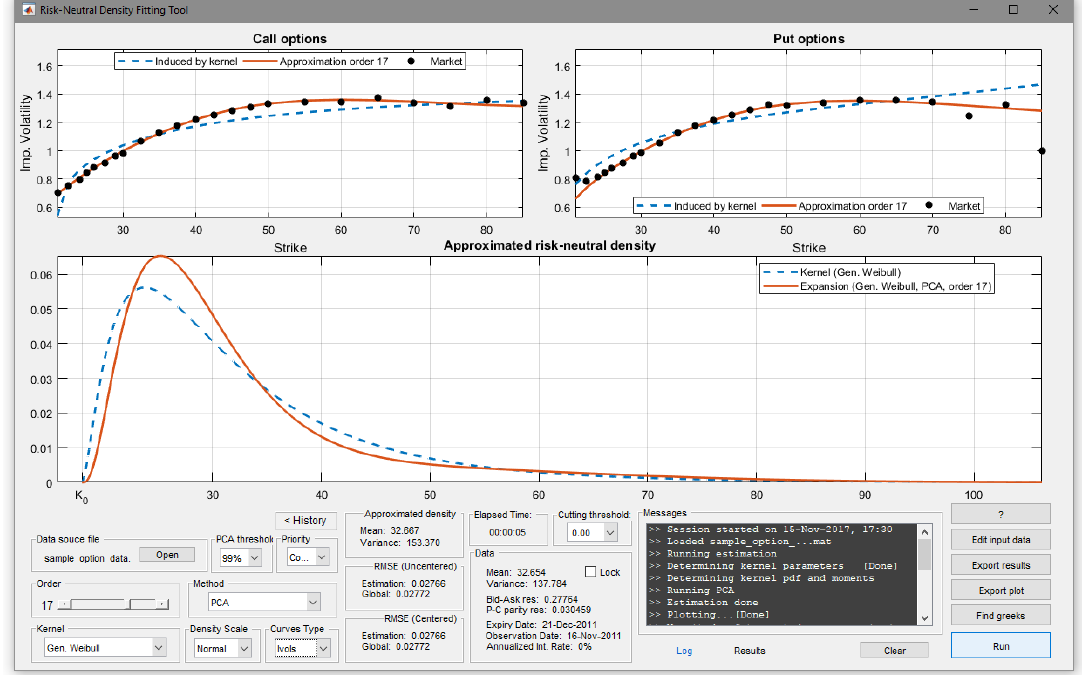
Figure 4. Risk-neutral density (RND) obtained with a Generalized Inverse Gaussian (GIG) kernel and expansion order n = 18 and 5 principal component analysis (PCA) components with a treshold of